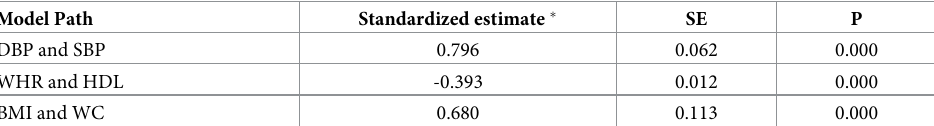
PLOS ONE | https://doi.org/10.1371/journal.pone.0219193 July 1,